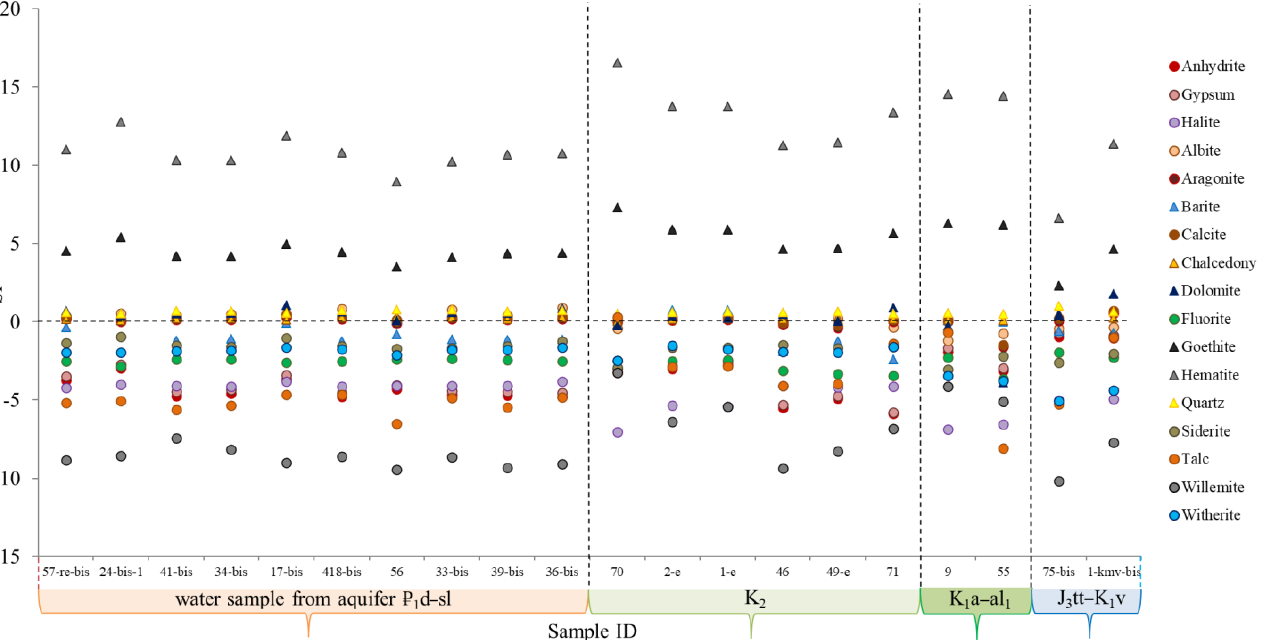
Figure 8. Saturation indices (SI) values of groundwater samples, with respect to minerals in the study area.